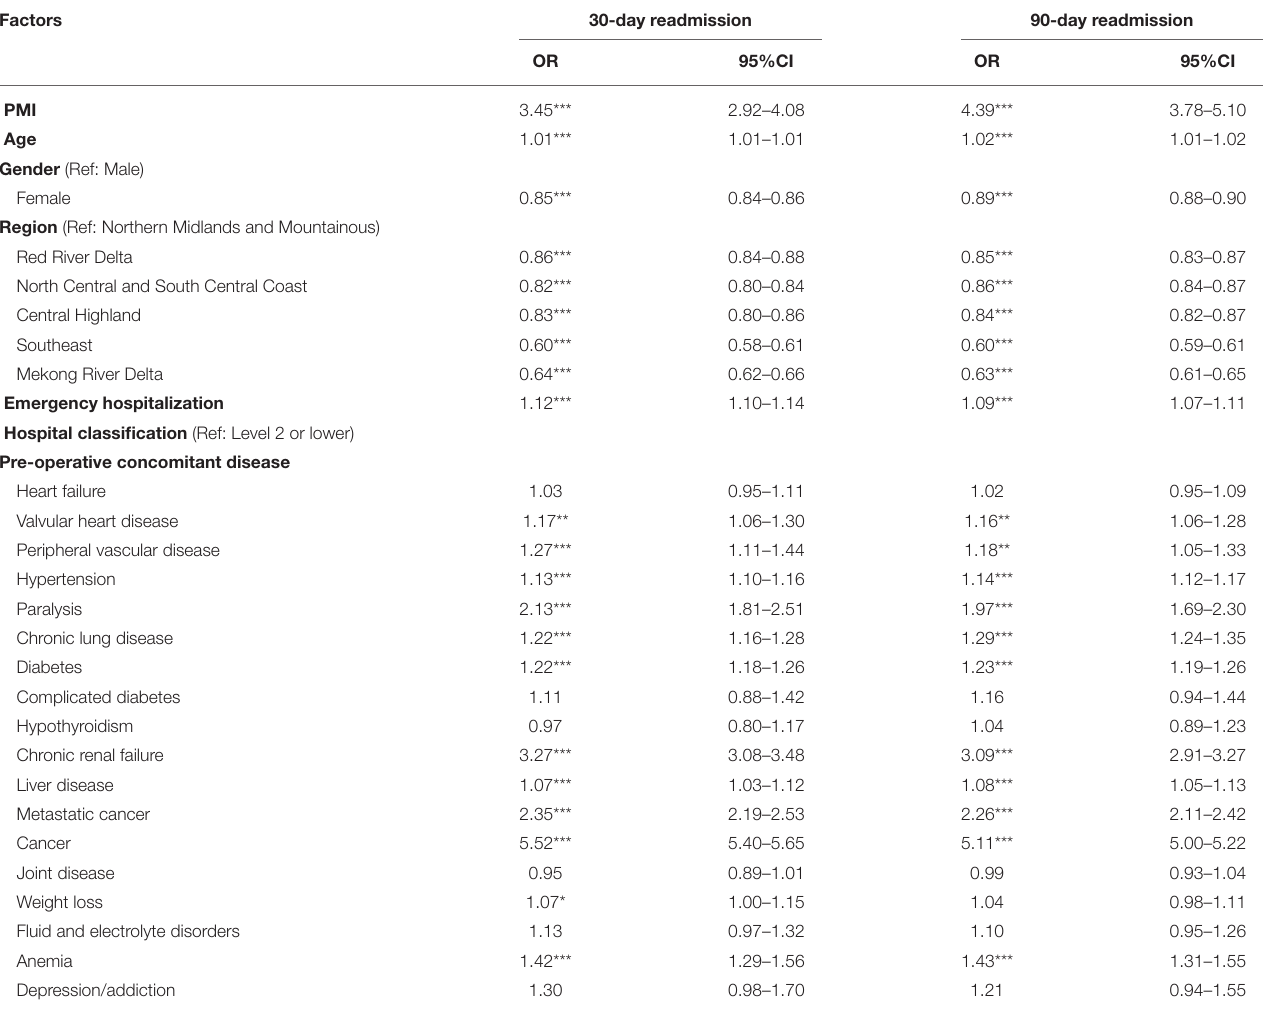
TABLE 2 | Impact of post-operative myocardial infarction on readmission within 30 and 90 days of surgical patients.